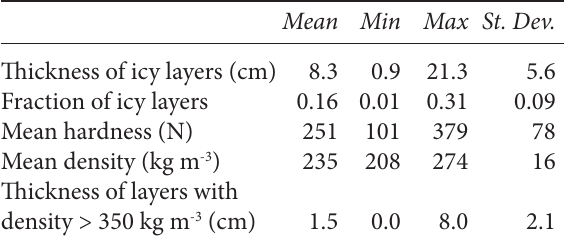
Table 4. Mean, minimum, maximum and standard deviation of whole winter mean values of the selected snow structural pa- rameters simulated by the SNOWPACK model in Muonio dur- ing Mean Min Max St. Dev.